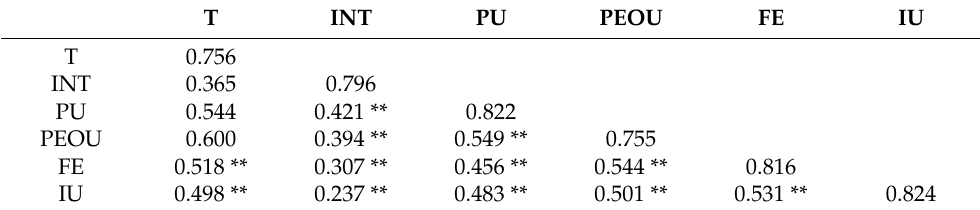
Table 5. Discriminant validity analysis.